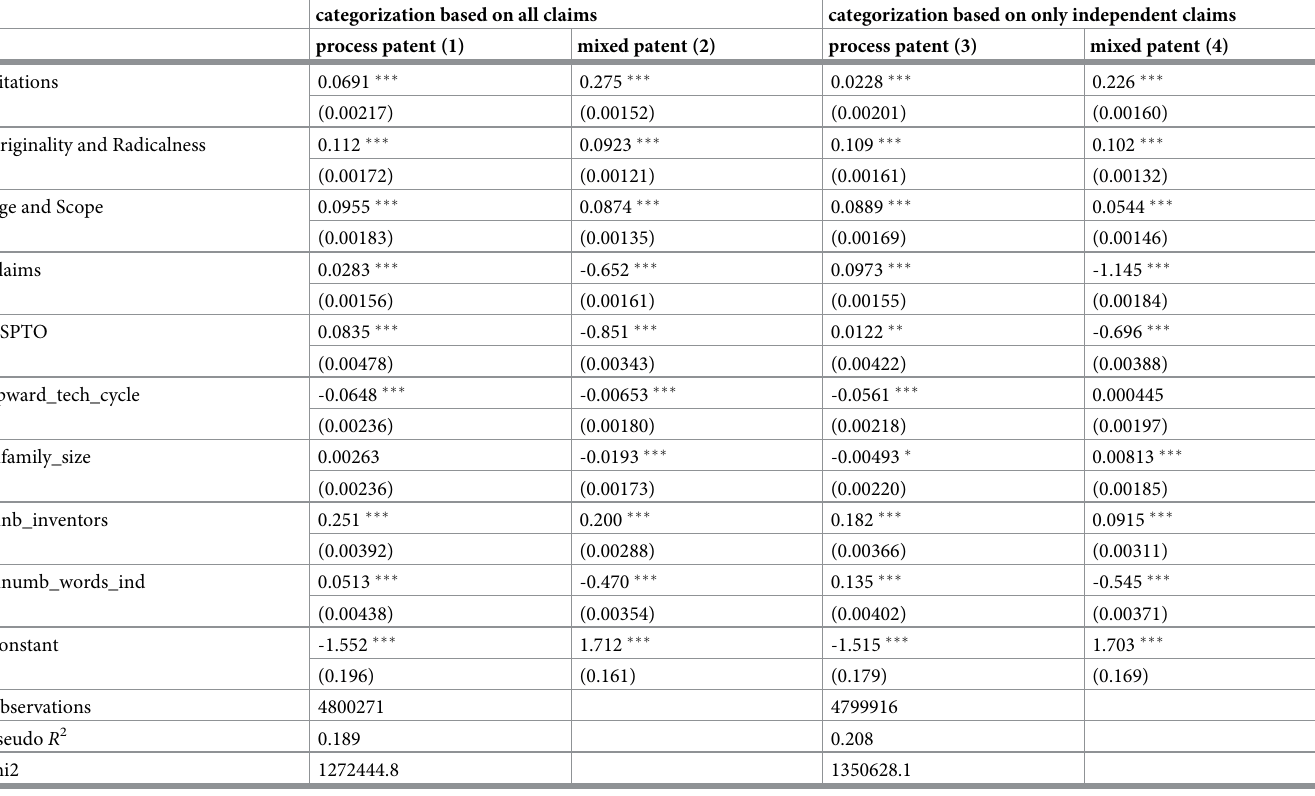
Table 6. Multinomial logit full model—dependent variable: Patent category, base category: product patent. categorization based on all